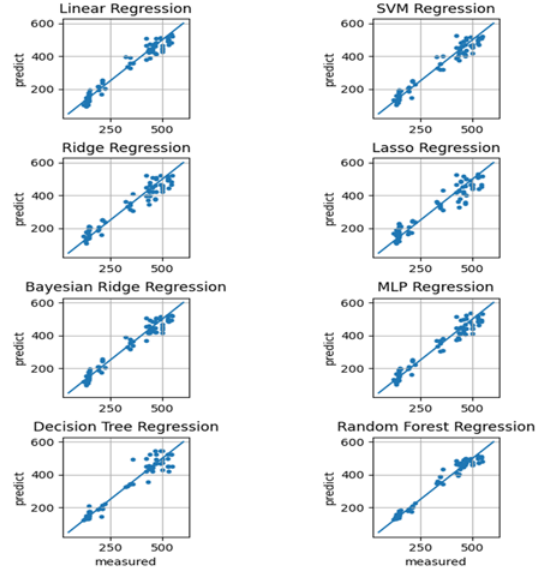
Figure 16. Scatterplot between predicted value and measured value for total (male and female) da ‐ taset.